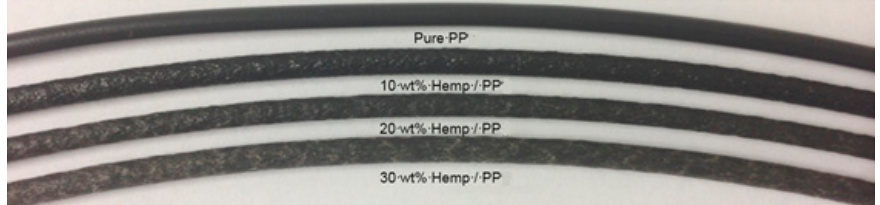
Figure 3. Surface finish of extruded hemp/polypropylene composite filaments.